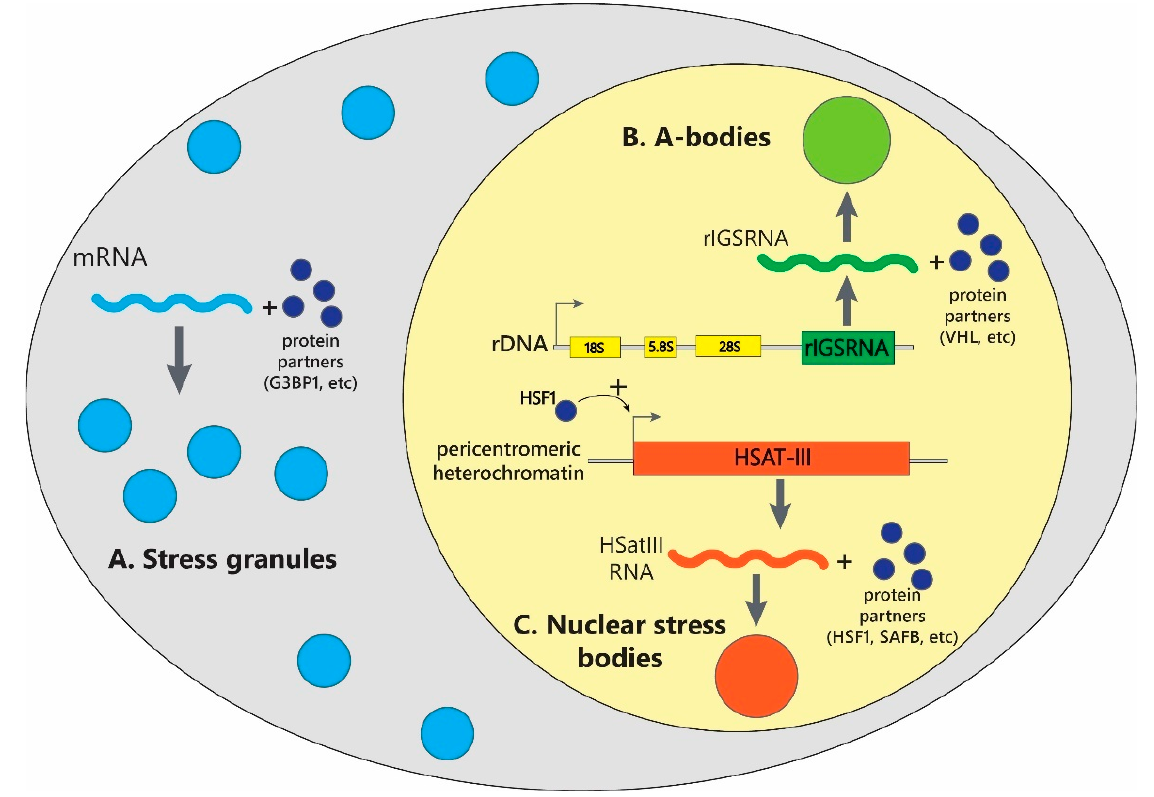
Figure 1. The schematic picture of formation of stress-induced MLOs in mammalian cells. The key players of stress-induced MLOs are shown. ( A ) Stress granules form in the cytoplasm as a result of stress-triggered release of untranslated mRNA from polyribosomes and its interaction with SGs core proteins, such as G3BP1 and others. ( B ) A-bodies form in the cell nucleus at the transcriptional loci of ribosomal intergenic spacer RNA (rIGSRNA), which transcription is activated upon stressful conditions from intergenic spacers of rDNA. Synthesized rIGSRNA interacts with VHL and other protein partners, leading to A-bodies formation. ( C ) Nuclear stress bodies assemble in the nucleus at the transcriptional sites of HSatIII RNA, located at the pericentromeric heterochromatin regions of chromosomes. HSatIII RNA transcription is promoted by HSF1 upon stress and via interaction with HSF1, SAFB and other protein partners drives condensation of nuclear stress bodies.